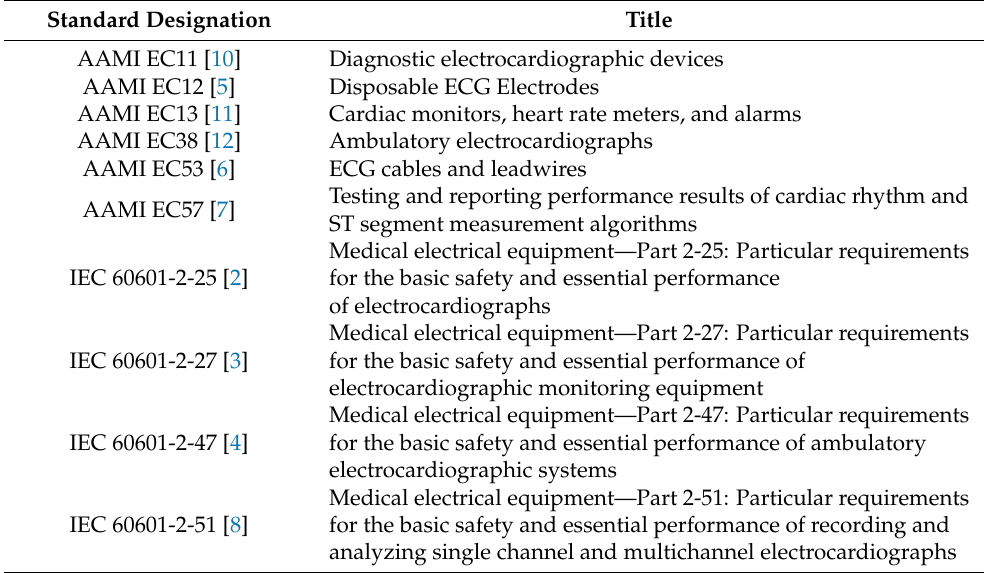
Table 1. List of historical industry standards that apply to ECG